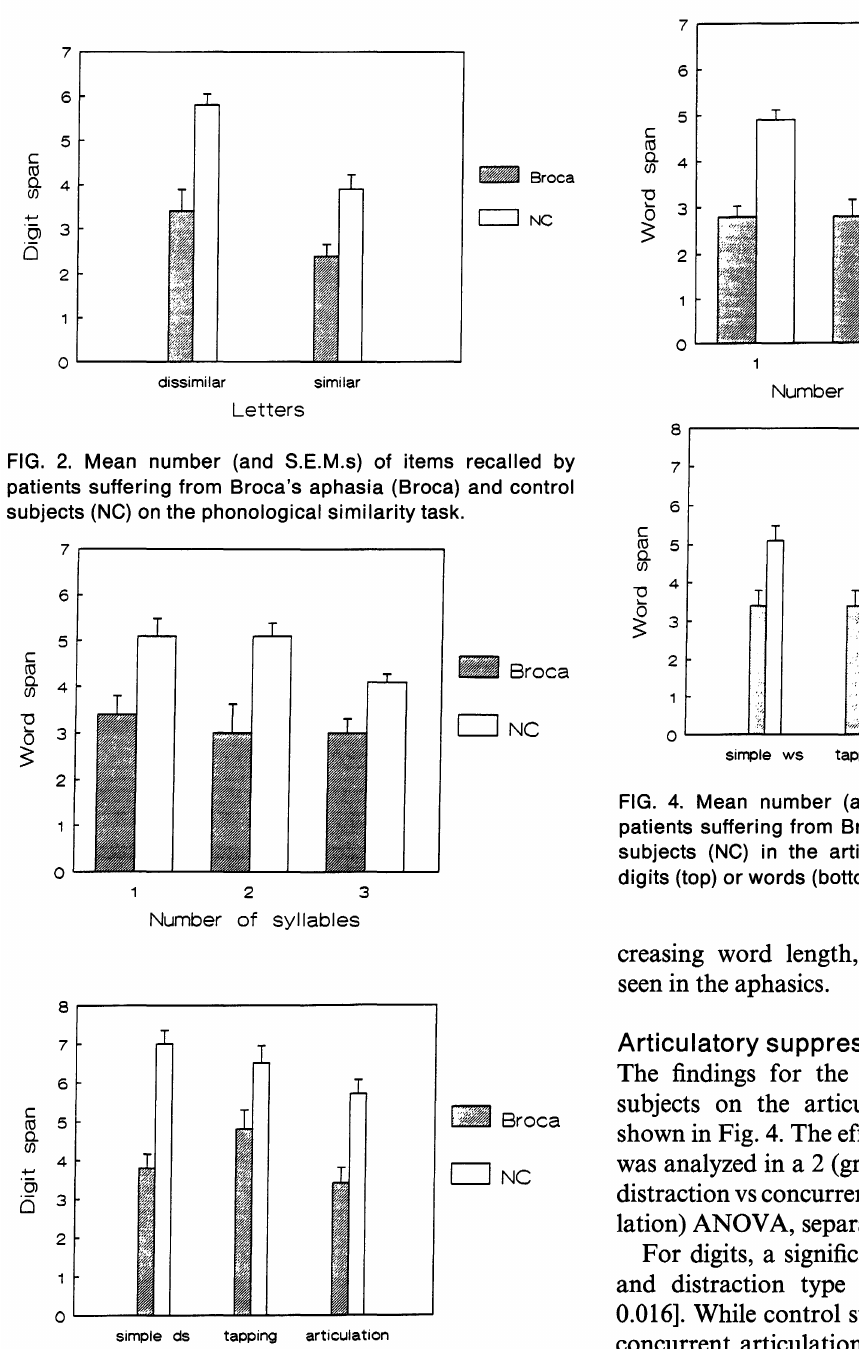
FIG. 3. Mean number (and S.E.M.s) of items recalled by patients suffering from Broca's aphasia (Broca) and control subjects (NC) in the auditory (top) and visual (bottom) word length tasks, respectively.